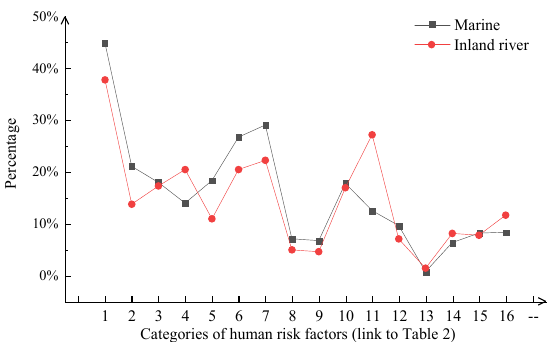
Through the statistics of the number of risk factors and sub-factors as described by accident reports, the proportion of the number of risk factors and sub-factors is obtained. The frequency of risk sub-factors in inland river and marine accidents is compared and analyzed and the results are depicted in Figures 6–9.